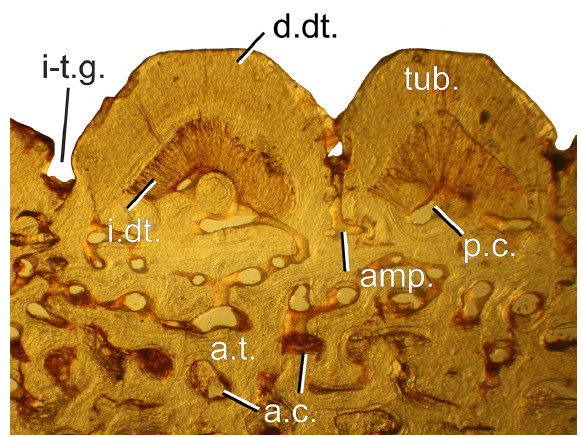
Fig. 8. Vertical thin section of branchial plate А .3-1, Pasta muiža, Latvia. Abbreviations: a.c., aspidin cavity; amp., ampullae; a.t., aspidin trabeculae; i.dt., inner dentine; i-t.g, intertubercular grooves; d.dt., dense dentine; p.c., pulp cavity; tub., dentine tubercles.